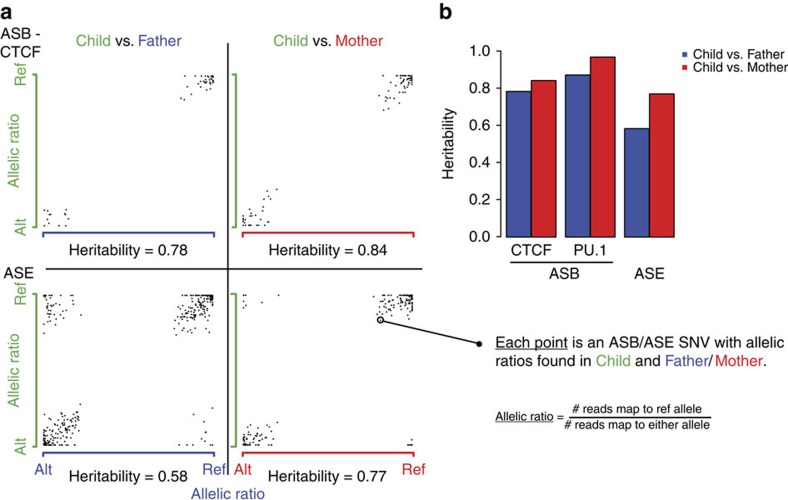
Inheritance of allele-specific behaviour.(a) The left panel shows plots for the TF CTCF (top row) and ASE (bottom row) being examined for inheritance in the CEU trio (Father: NA12891, blue; Mother: NA12892, red; Child: NA12878, green). Each point on the plot represents the allelic ratio of a common ASB SNV between the parent (x-axis) and the child (y-axis), by computing the proportion of reads mapping to the reference allele at that SNV. High Pearson's correlations, r, observed in both parent-child comparisons for CTCF (r≥0.78) signify strong heritability in allele-specific behaviour. ASE also shows considerably strong evidence of heritability but has comparatively lower r values. (b) The bar plot at the top right panel presents the r values for ASB in two TFs and ASE in our analyses.